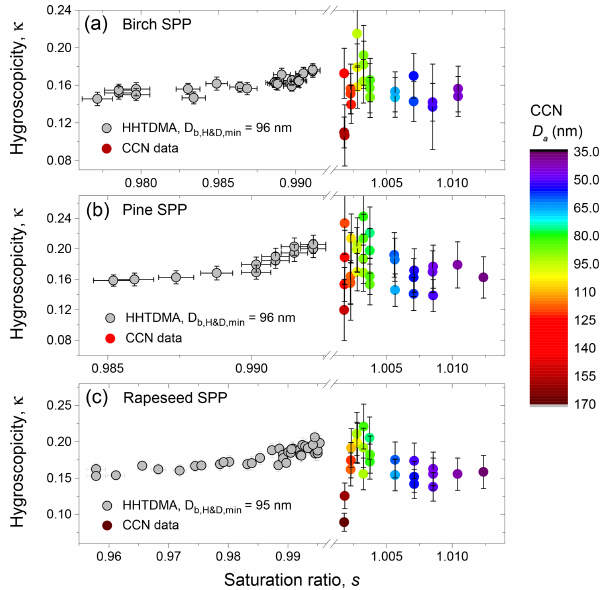
Figure 11. HHTDMA-based and CCN-based hygroscopicity pa- rameter, κ , for birch (a) , pine (b) , and rapeseed (c) SPPs as a func- tion of RH. The color code shows the CCN-derived κ a with respect to the shape-corrected activation diameters, D a